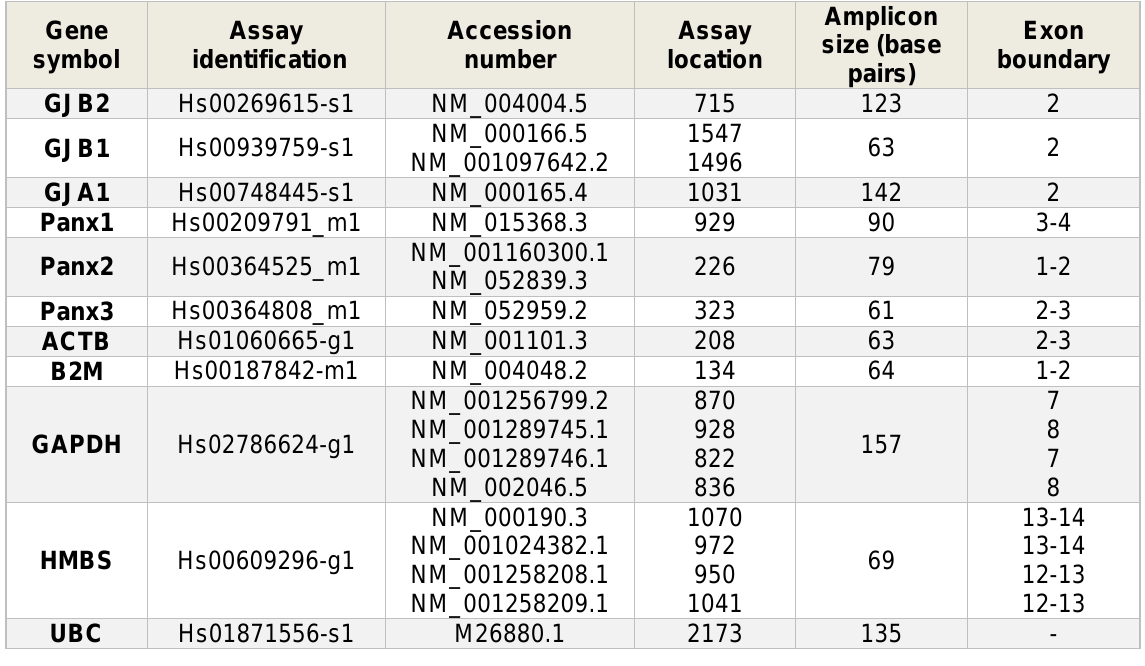
Table 2: Primers and probes used in the RT-qPCR analysis. Assay identification, accession num- ber, assay location, amplicon size and exon boundaries are listed (GJB2, Cx26; GJB1, Cx32; GJA1, Cx43; ACTB, actin beta; B2M, beta-2-microglobulin; GAPDH, glyceraldehyde-3-phosphate